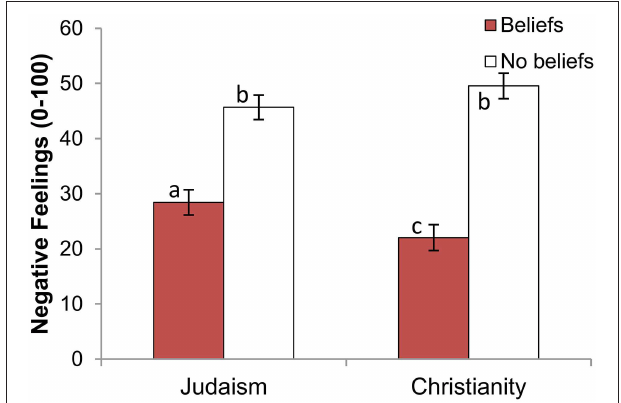
FIGURE 3 | Negative feelings toward target, by target religion and target level of beliefs (Protestant participants only). Error bars indicate ± 1 SE. Different subscripts indicate that these bars differ from each other at the p < 0 . 05 level.